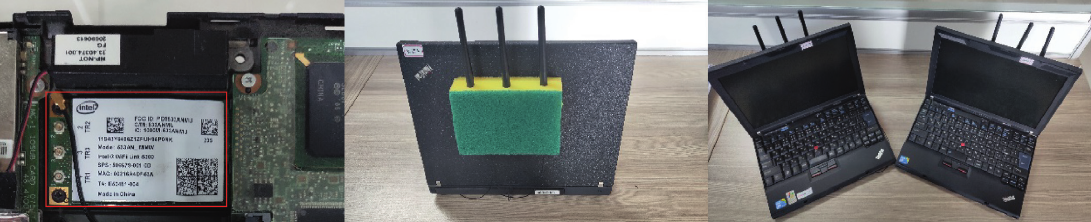
Figure 10: Experimental